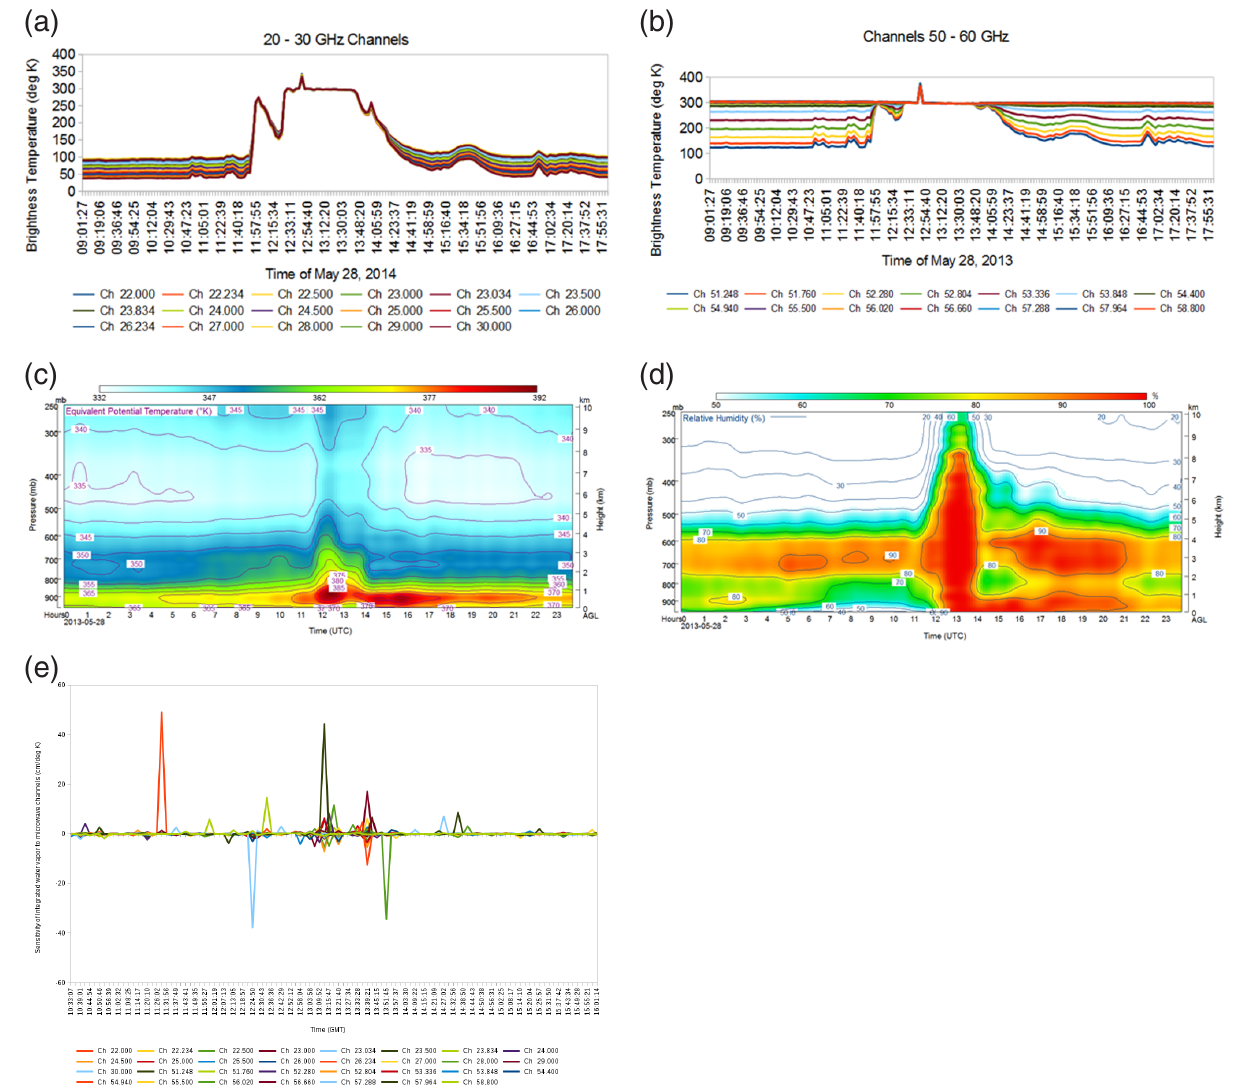
Figure 1. Sensitivity of 31 microwave brightness channels measured by MWR at (a) 20–30GHz and (b) 50–60GHz and the composite of vertical profiles of equivalent potential temperature (c) and relative humidity (d) retrieved during a convection event on 28 May 2013 over NARL Gadanki using MWR (ANN algorithm). The time resolution of these profiles is 4min. (e) Sensitivities of integrated water vapour to brightness temperatures observed by MWR (rate of changes in integrated water vapour with respect to changes in brightness temperatures in each channel at a constant time